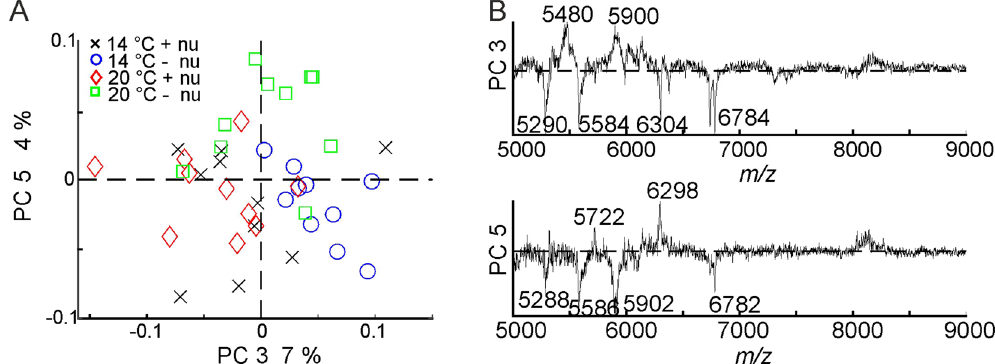
Figure 5. ( A ) Scores plot using PC 3 and PC 5 as a result of a PCA using the mass range m/z 5000–9000 with the individual spectra of the samples obtained from Italian population of P. alpina population PAp2. Each of the four cultivation conditions is represented by 10 individual spectra. Abbreviations in the figure legend: + nu, additional nutrients, − nu, no additional nutrients. ( B ) Corresponding loadings of PC3 and PC 5.